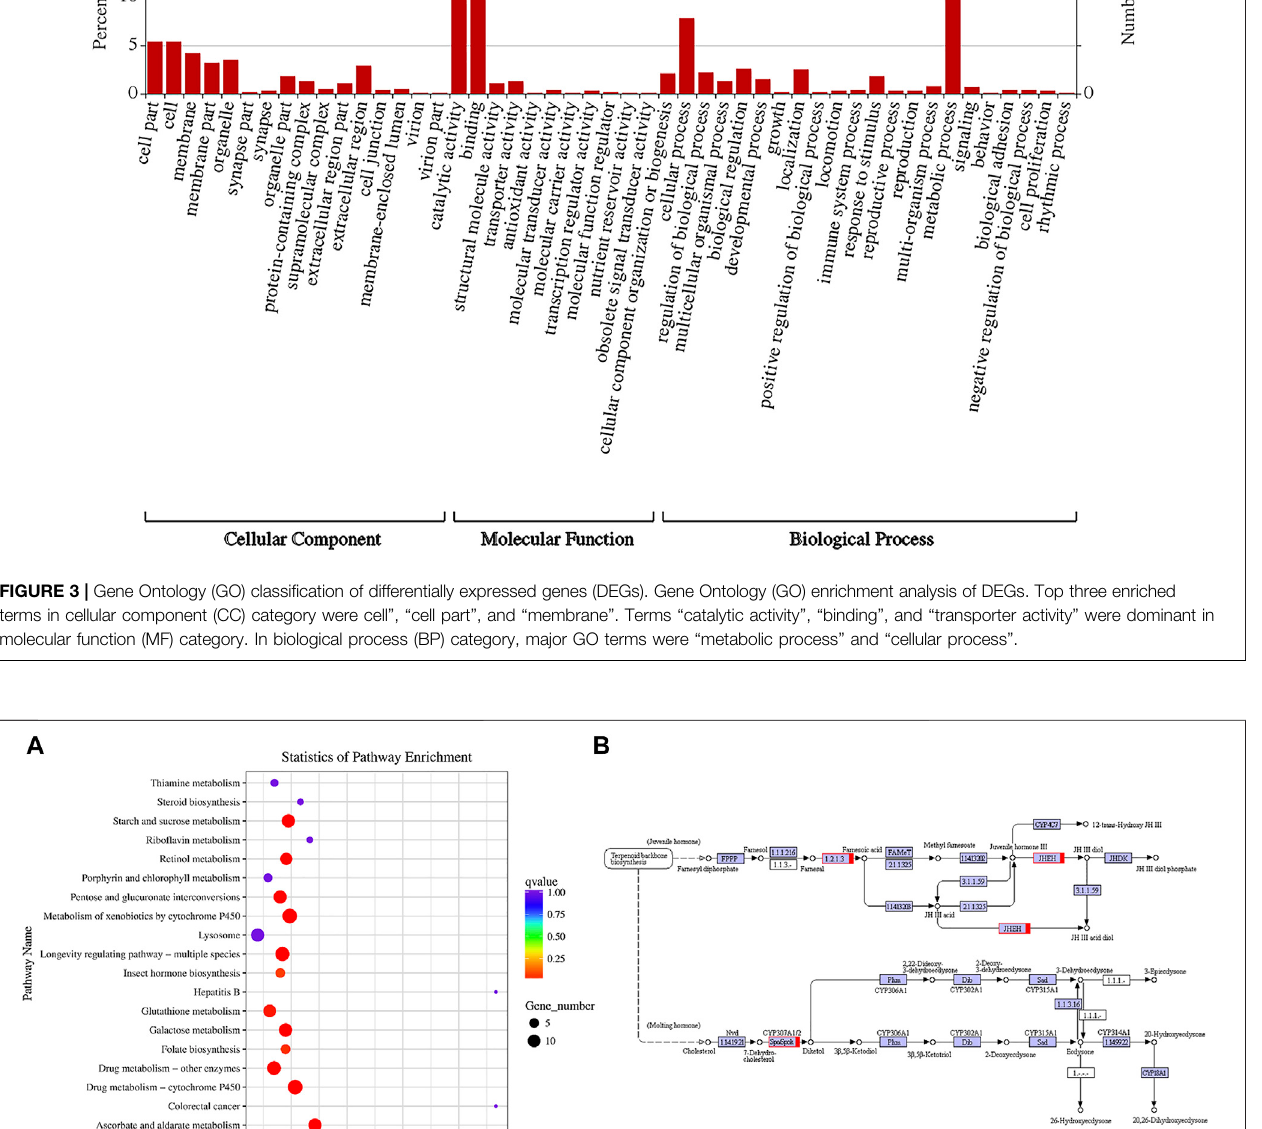
Frontiers in Physiology |